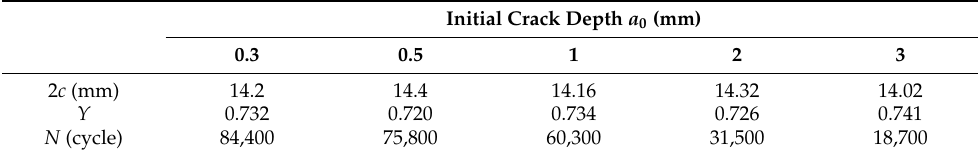
Figure 11. The changing trend of shape ratio during initial semi-elliptical surface crack growth.